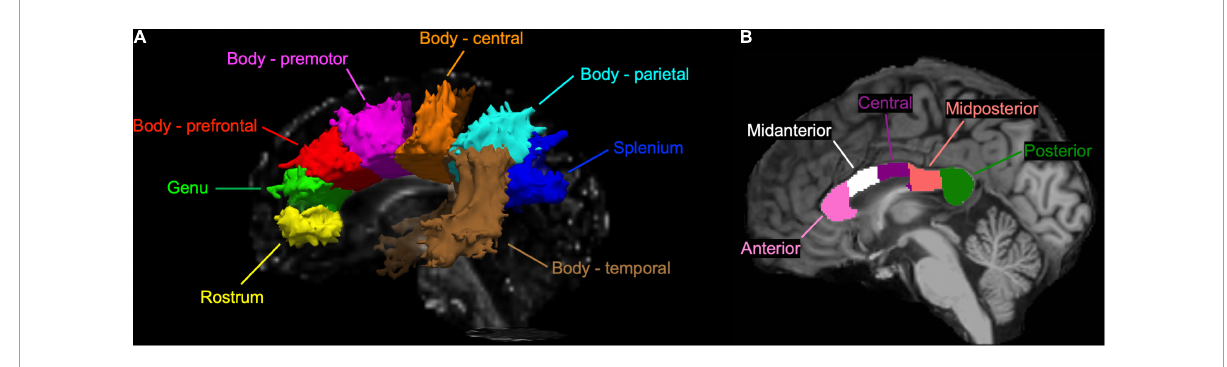
FIGURE1 (A) A sagittal view of the corpus callosum (CC) tracts reconstructed by the TRActs Constrained by UnderLying Anatomy (TRACULA) in a single participant of the present study. Each tract is displayed at 20% of its peak probability. (B) A sagittal view of the CC subsections segmented in T 1 -weighted structural image of the same participant.